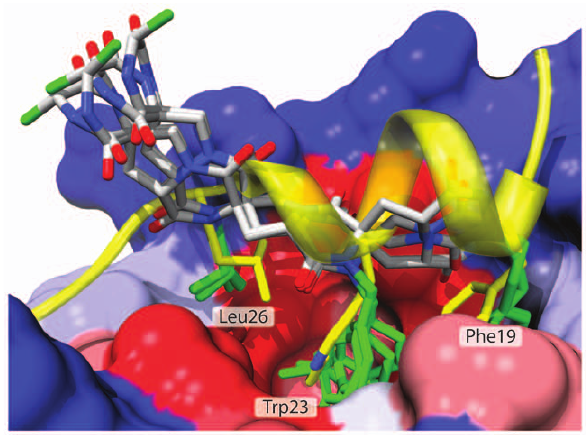
Figure 1. The modeled structures of the four diastereomeric spiroligomers 1, 8, 9, and 11 (white, blue, red and green tubes) superimposed onto the p53 helix (yellow ribbon) within the binding pocket of HDM2 (surface) showing the similar presentation of the functional groups (designated green), which can be tuned by changing the stereochemistry of the spiroligomer backbone.